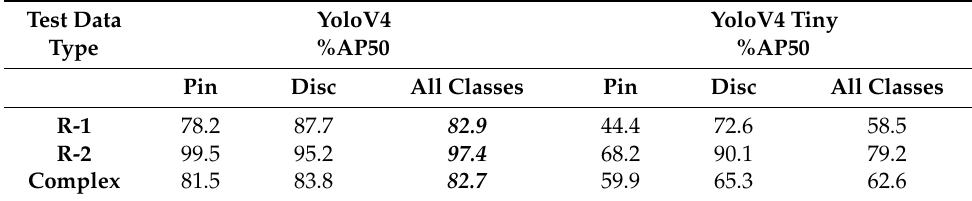
Table 3. Test results of YoloV4 and YoloV4 Tiny for different datasets.